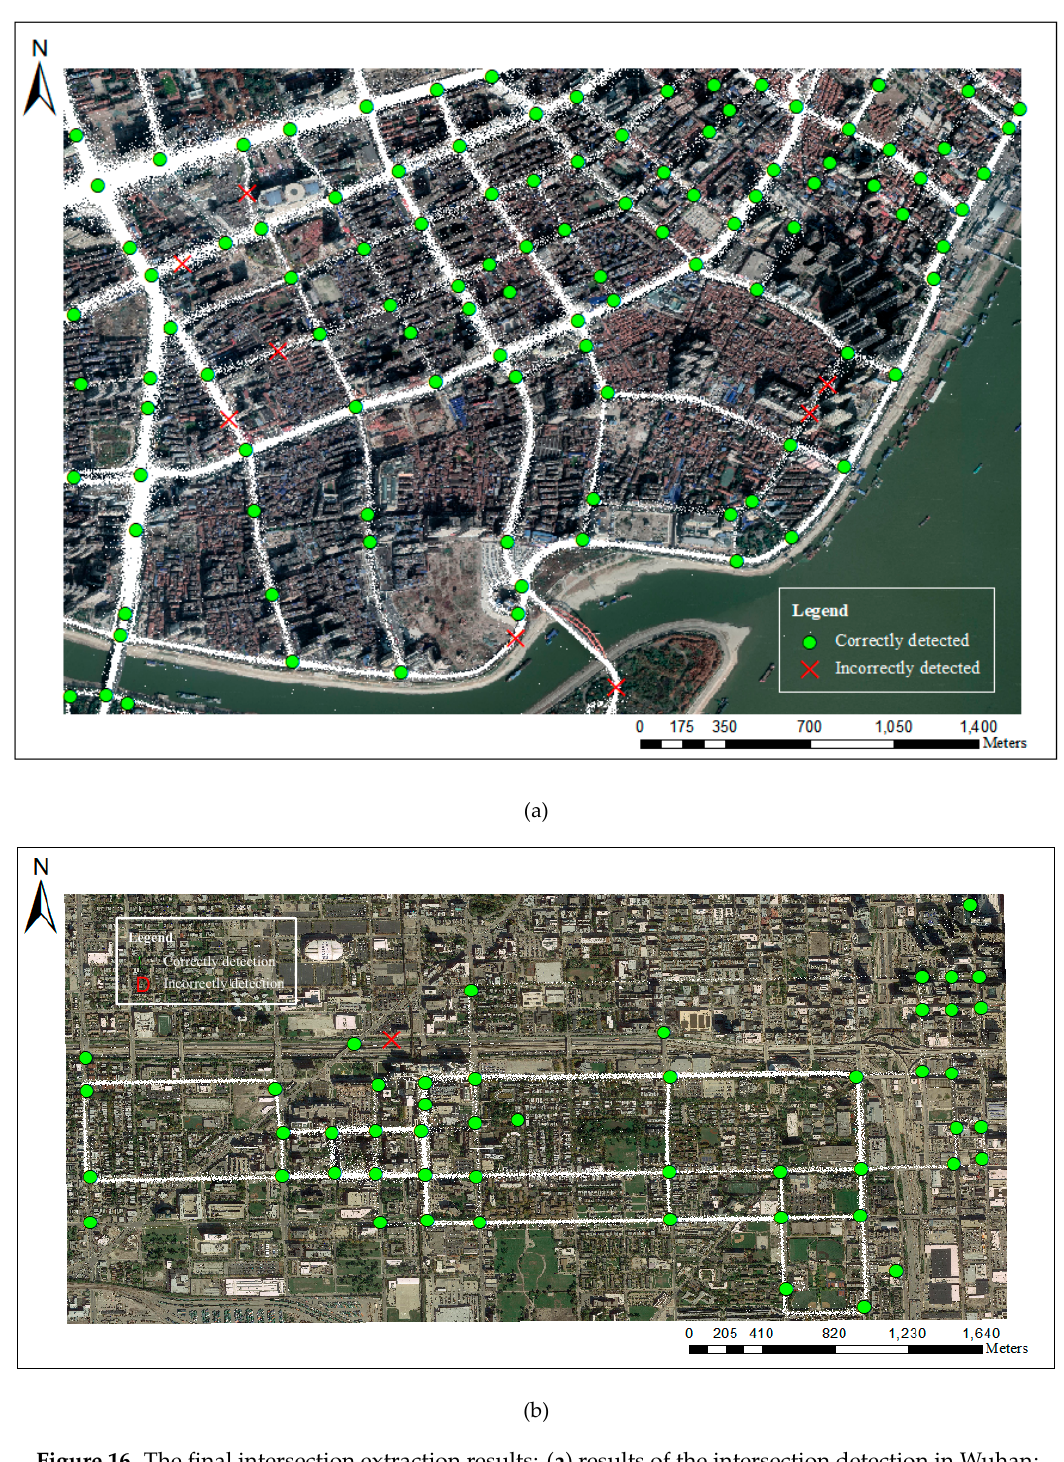
Figure 16. The final intersection extraction results: ( a ) results of the intersection detection in Wuhan; ( b ) results of the intersection detection in Chicago.